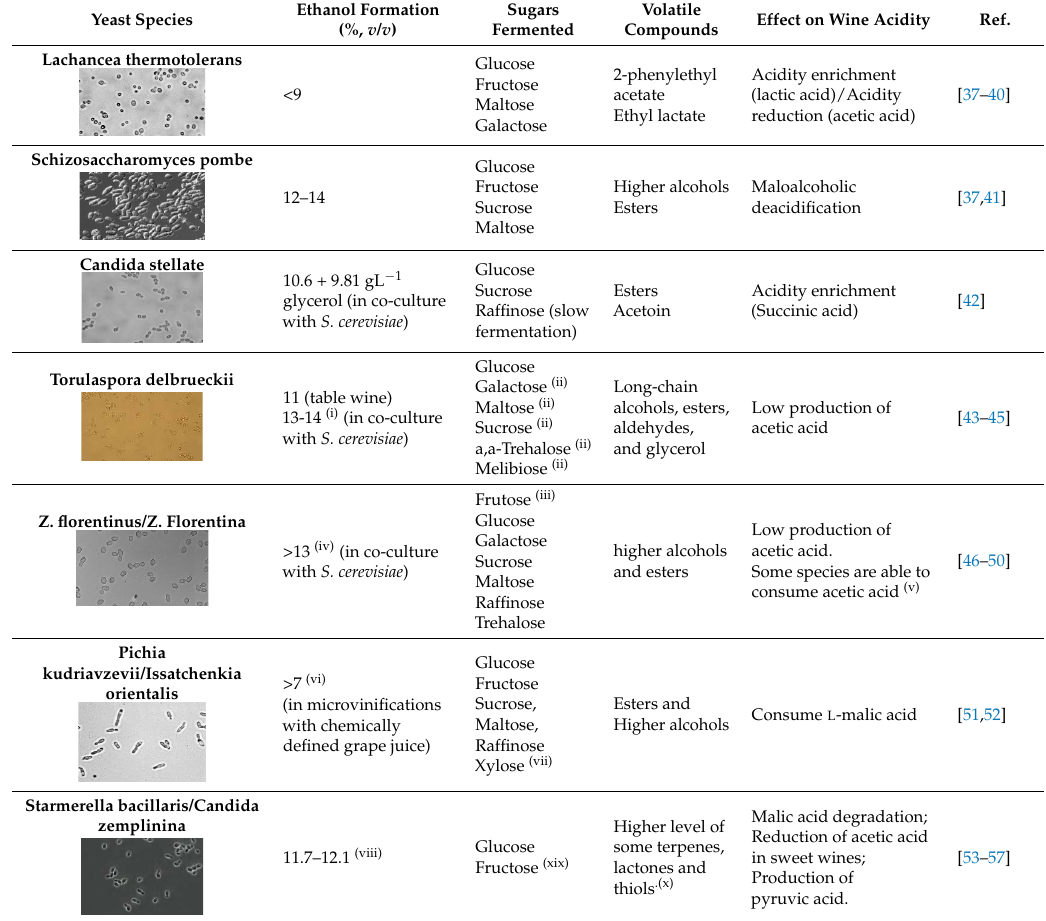
Z. florentinus/Z. Florentina